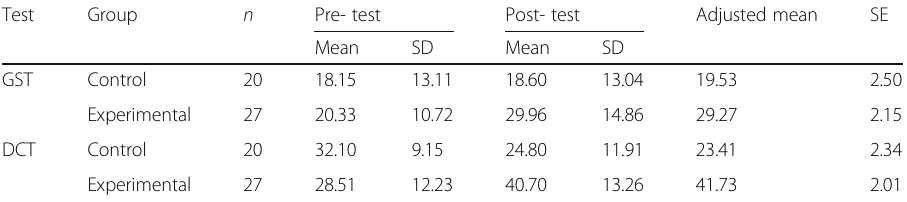
Table 1 Means and Standard Deviations of the Students ’ Performance on the Pre- and Post- GST and DCT